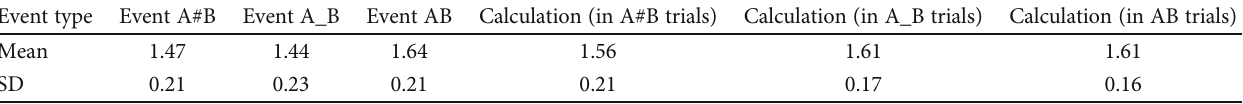
Table 1: Mean reaction time (sec) ( N = 12 ).